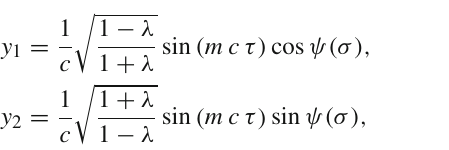
to a point. One can also consider open strings which end on a D0-brane at the tip of the cigar. The right panel of Fig.